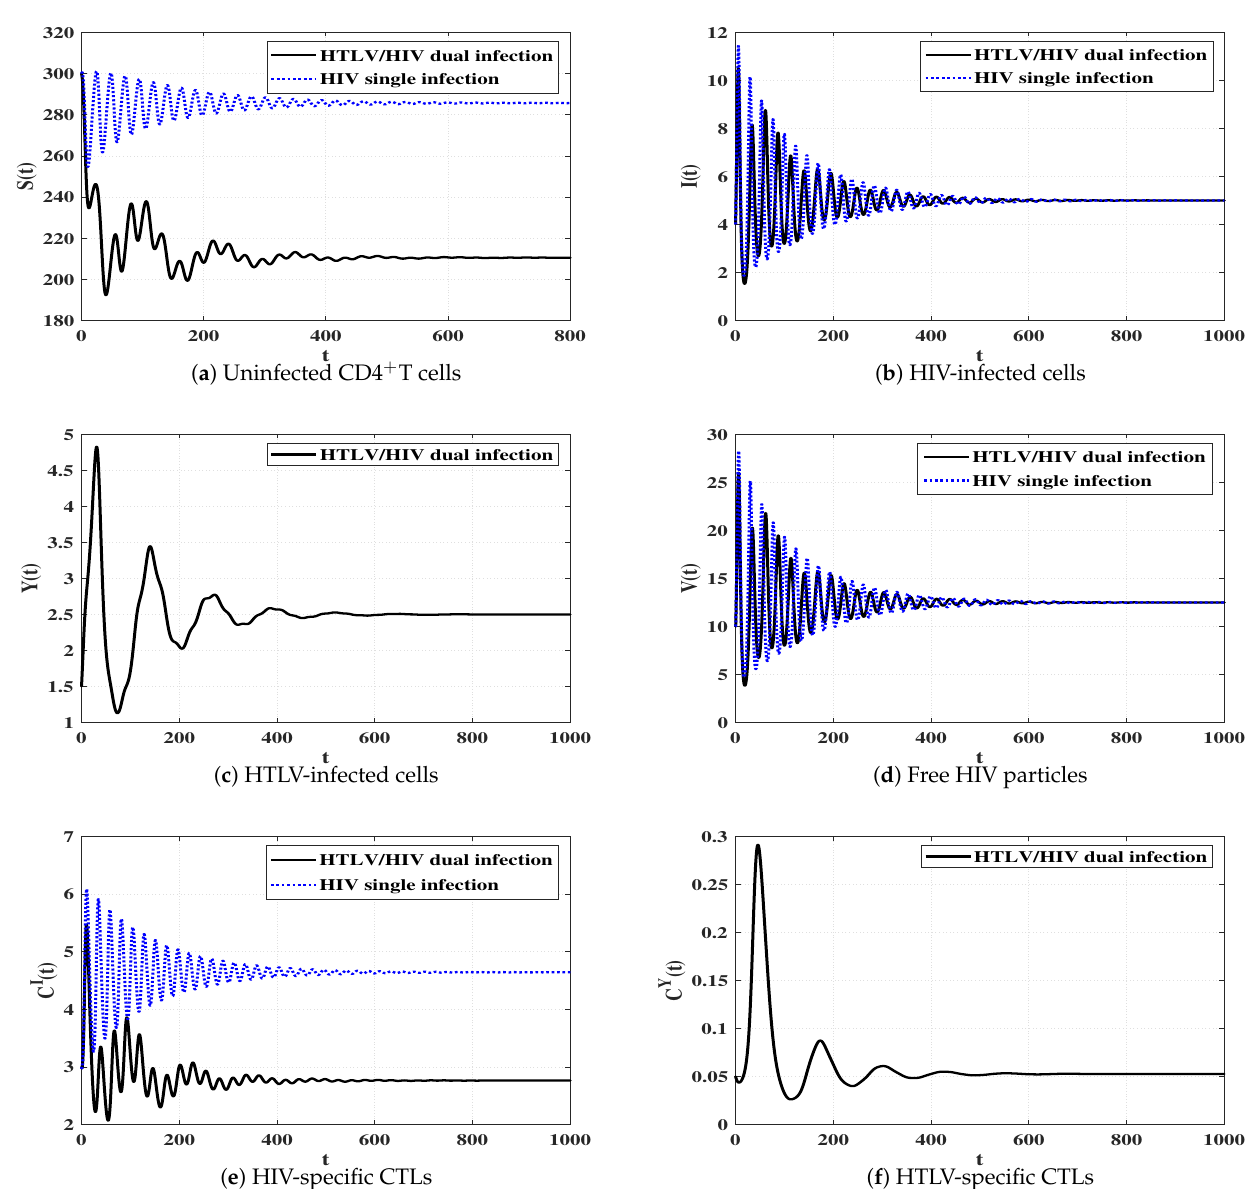
Figure 10. Comparison between the dynamics of HIV single infection and HTLV/HIV dual infection. Influence of HIV infection on the dynamics of HTLV single infection To see the effect of HIV infection on the dynamics of HTLV single infection, we perform a comparison between models (3) and